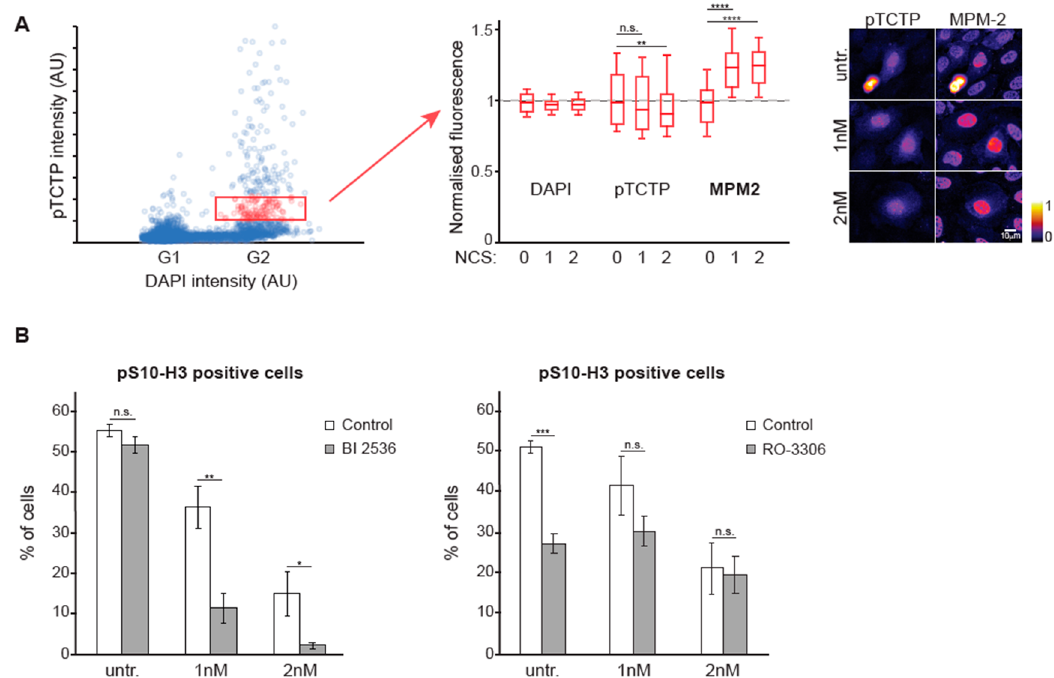
Figure 4. The balance between PLK1 and CDK1-mediated phosphorylation is altered during recovery. ( A ) 10 h after treatment with 2 nM NCS, U2OS cells were fixed and stained with phosphorylated TCTP (pTCTP, a proxy for PLK1 activity) and MPM-2 (a proxy for CDK1 activity) antibodies. Integrated intensities of DAPI and pTCTP were used to identify early G2 cells (indicated in red rectangle), whose levels of DAPI, pTCTP and MPM-2 are plotted in the graph on the right. Values are normalized to the average intensity in the absence of NCS. Representative images are shown to the right. ( B ) U2OS cells were treated with di ff erent concentrations of NCS, and after 4 h were either cotreated with DMSO, 10 nM of the PLK1 inhibitor BI 2536 (left panel) or 5 µ M of the CDK1 inhibitor RO-3306 (right panel). 16 h after damage induction, cells were fixed and stained with a pS10-histone H3 specific antibody. All samples were treated with 10 µ M of S-trityl-L-cysteine (STLC) to trap cells in mitosis. Samples were analyzed by flow cytometry. The graph shows the mean and standard error of 3 independent experiments. n.s. (not significant) indicates p > 0.05, * indicates p < 0.05, ** indicates p < 0.01, *** indicates p < 0.001 and **** indicates p < 0.0001 using Student’s T -test.